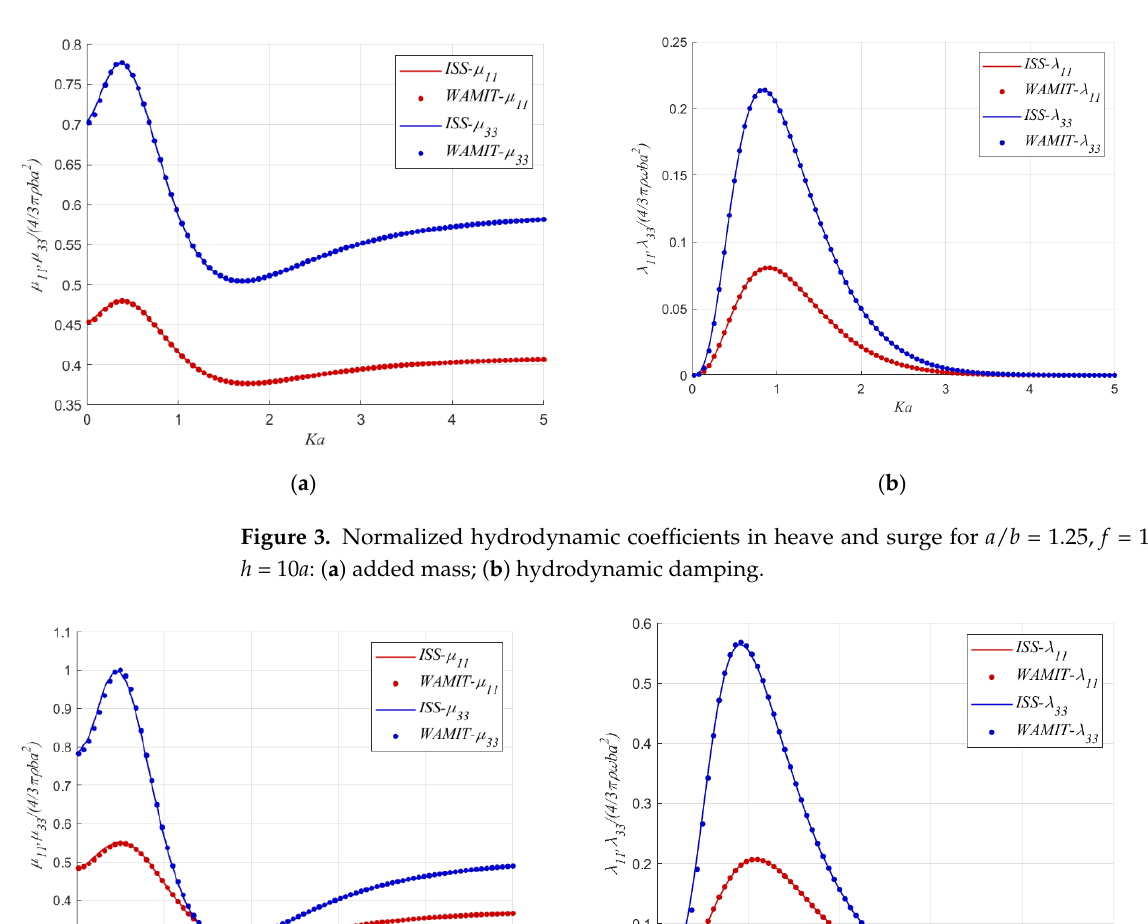
Figure 2. Normalized hydrodynamic coefficients in heave and surge for a/b = 1.25, f = 1.5a and h = 20a: ( a ) added mass; ( b ) hydrodynamic damping.